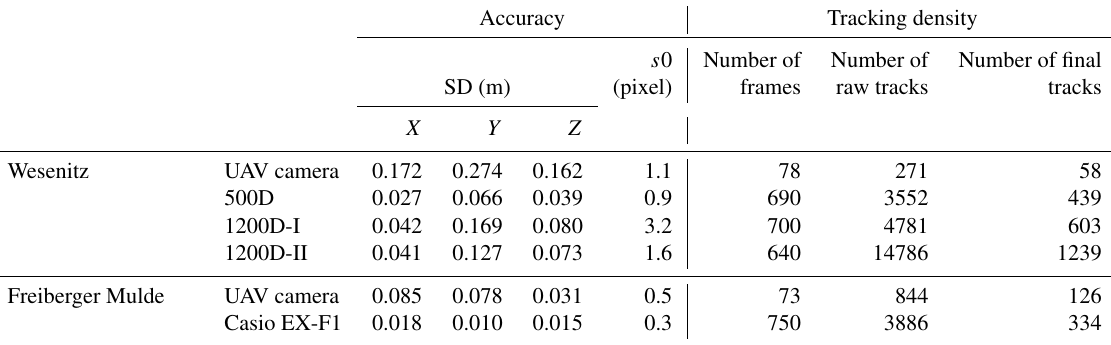
Table 2. Accuracy of camera pose estimation and density of tracking results. s 0 corresponds to the average reprojection error after the adjusted spatial